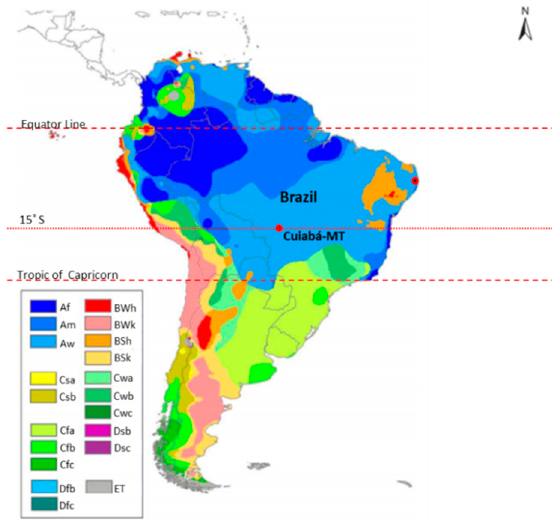
Figure 1. Location of the city of Cuiabá in South America. Source: adapted from Peel et al. [4]. The Brazilian Association of Technical Standards (ABNT) for Bioclimatic Zoning establishes a set of technical and constructive recommendations for the region, to optimize the thermal performance of buildings through a better climatic adaptation [16]. The recommendations and constructive guidelines for adequate LIH for the Savannah climate region are detailed in Table 1, in accordance with the Brazilian Bioclimatic and as prescribed by the Brazilian Technical Quality Regulation for Energy Efficiency Level of Residential Buildings (RTQ-R) [25]. As indicated in Table 1, thermal mass for cooling is a strategy recommended to adapt the building to the climate where it is located. Thus, this research focuses on verifying if this potential passive strategy may be adequate to adapt a building to the projected climate change